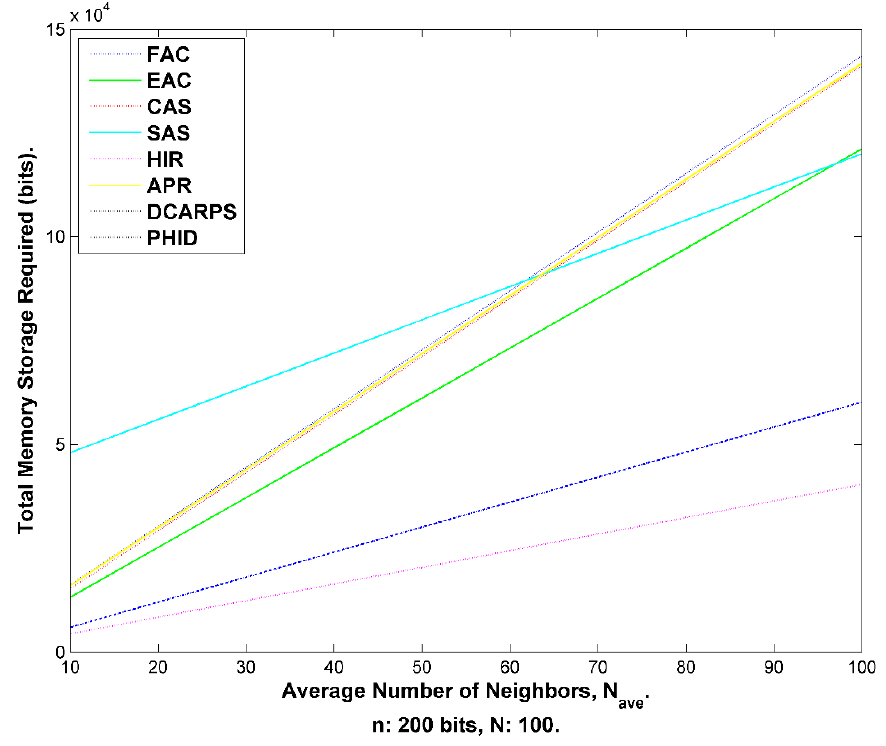
Figure 29. Size of storage memory using different privacy